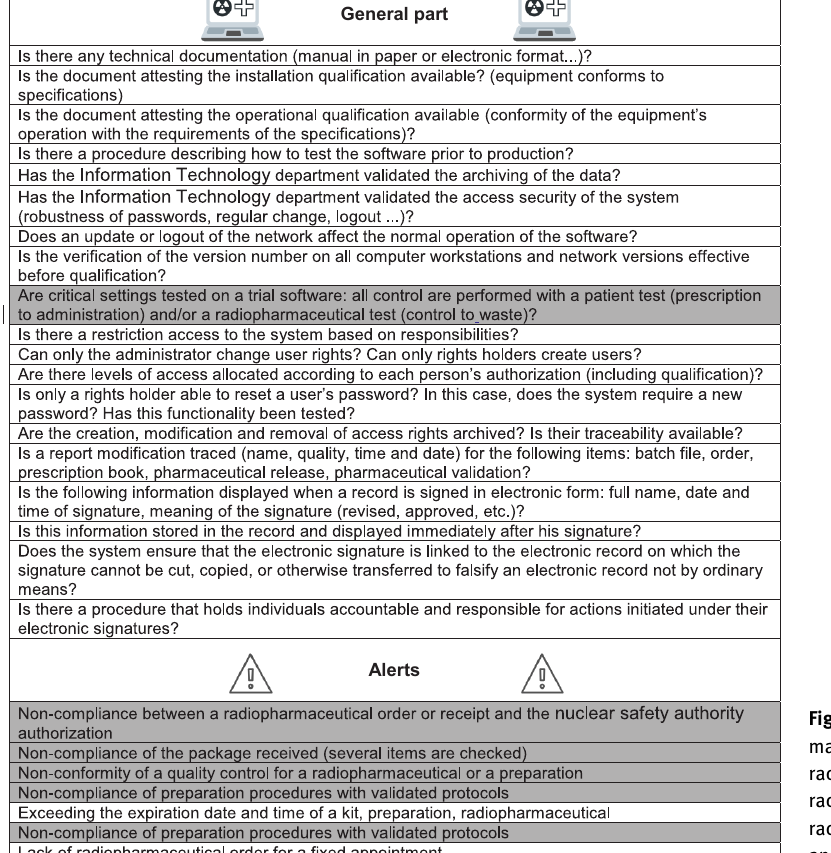
Figure 2: Validation of software system managing kits, generators, radiopharmaceuticals, radiopharmaceutical preparations and radioactive implantable medical devices and their interfaces: consensual